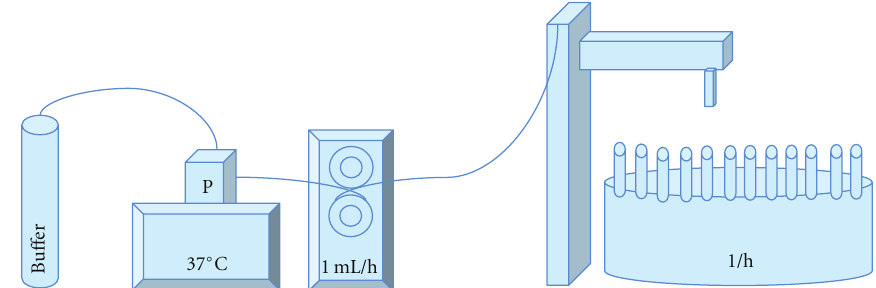
Figure 3: Continuous flow chamber modified according to Perry et al. [51].